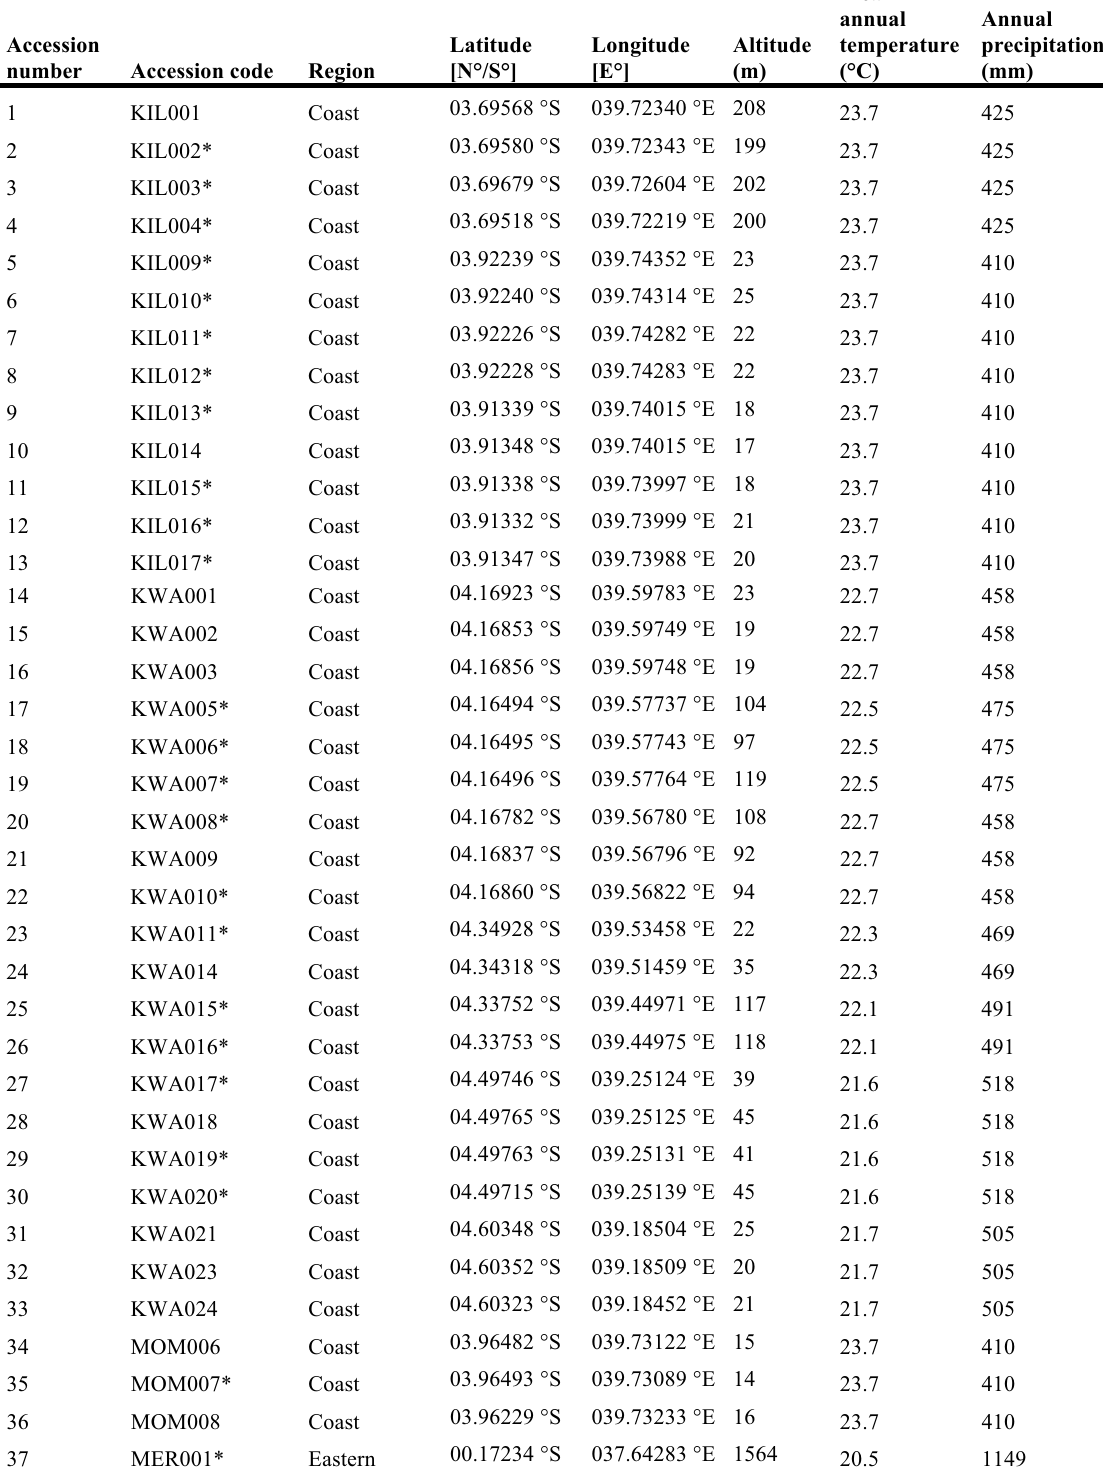
Tab. S1: Geographical coordinates, altitude, mean annual temperature, and annual